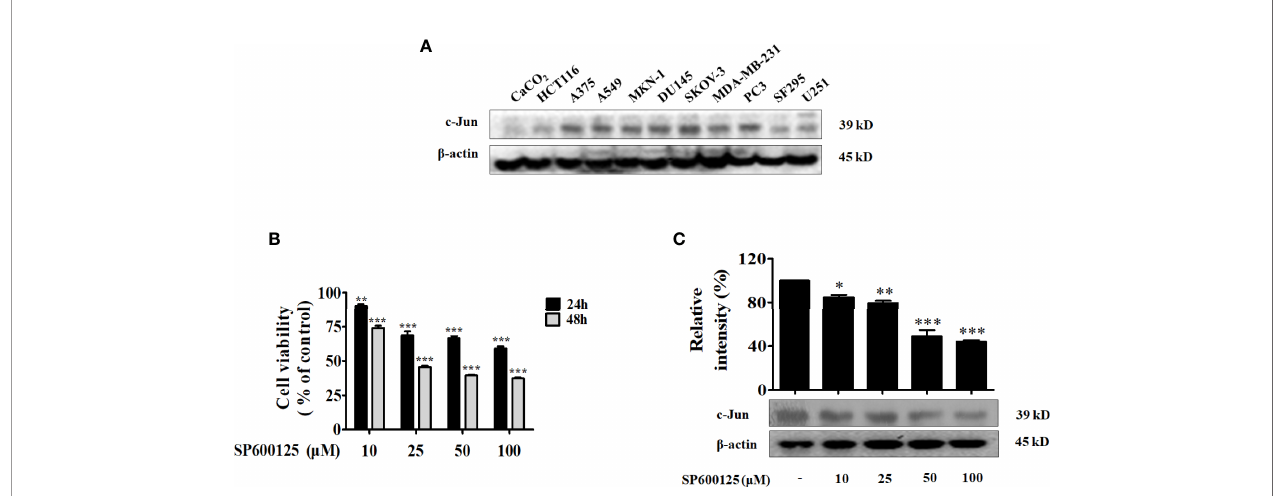
FIGURE 1 | A549 was most sensitive to JNK inhibitor SP600125. (A) The expression of c-Jun in various tumor cells (CaCO 2 , HCT116, A375, A549, MKN-1, DU145, SKOV-3, MDA-MB-231, PC3, SF295, and U251) was determined by Western blot. (B) A549 cells were incubated with various concentrations (10, 25, 50, and 100 m M) of JNK inhibitor SP600125 for 24 h or 48 h. Cell viability was determined by MTT assay. (C) The cell lysates were collected and immunoblotted with antibody for c-Jun after treatment with 10, 25, 50, and 100 m M of SP600125 for 48 h, the relative ratios of c-Jun was calculated by analyzing immunoblot band intensities. Data show the mean ± SD of three independent experiments. *p < 0.05, **p < 0.01, and ***p < 0.001, compared to the non-treated